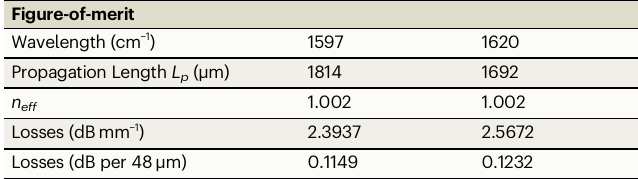
Table 1 | Figures-of-merit of the DLSPP waveguide in air Figure-of-merit